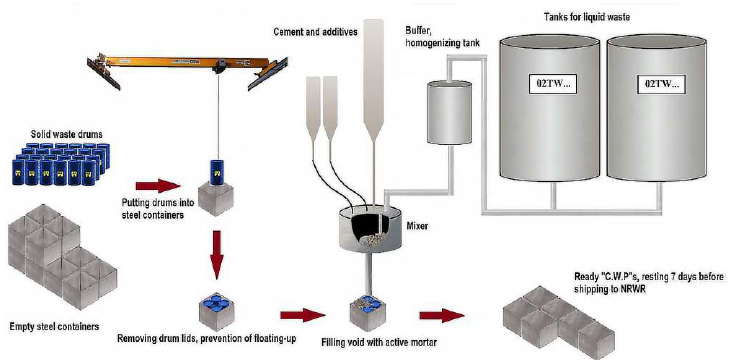
Figure 3. Preparation of solid radioactive waste for disposal at the Hungarian nuclear power plant [35].